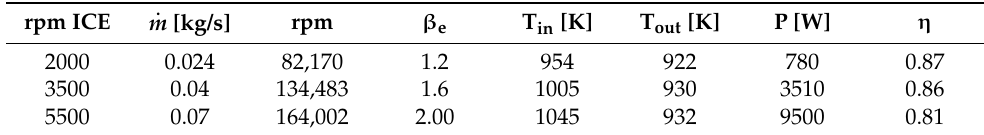
Table 4. GT20 turbine operation at different ICE engine rotation regime.